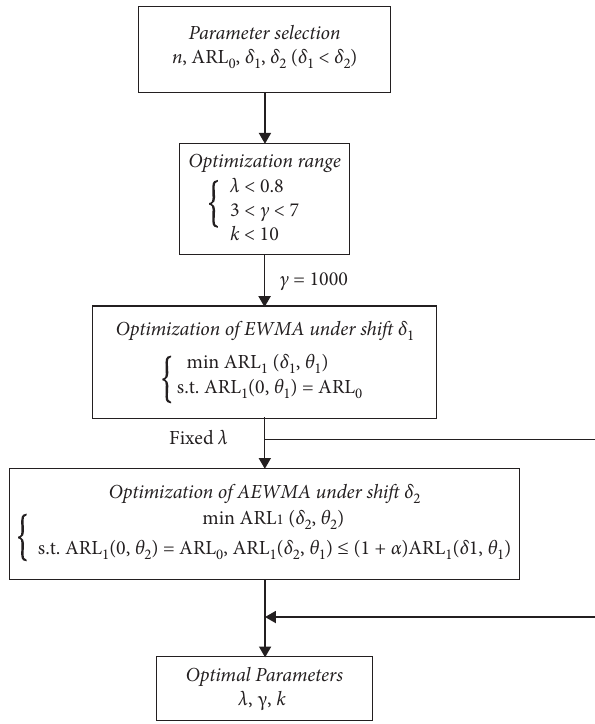
Figure 1: Flowchart for the optimal design of AEWMA control